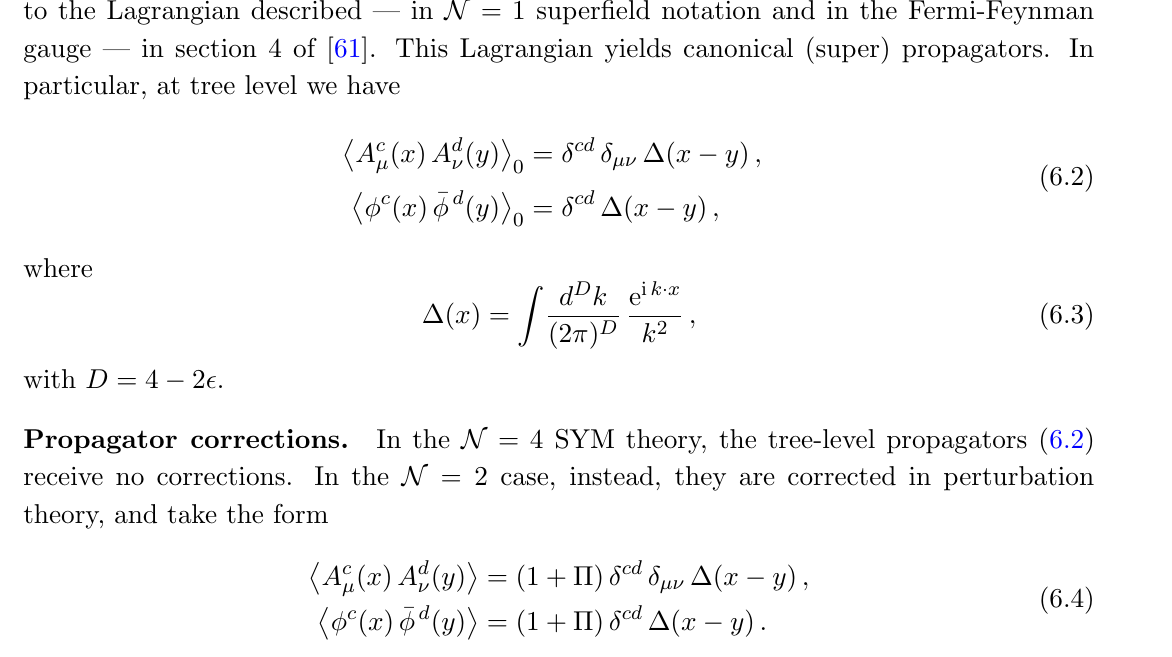
Figure 2 . The contour of a Wilson line with cusp angle ’